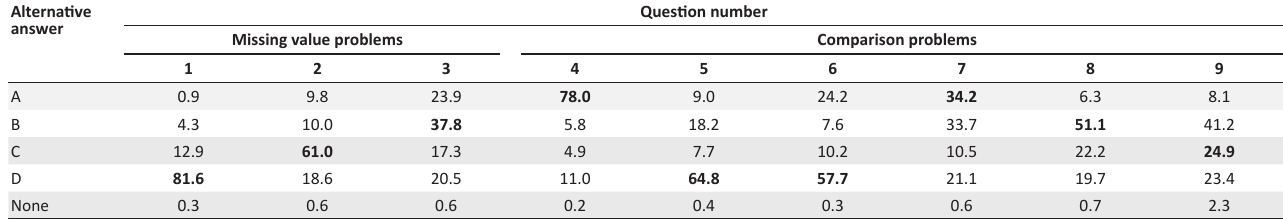
Question number